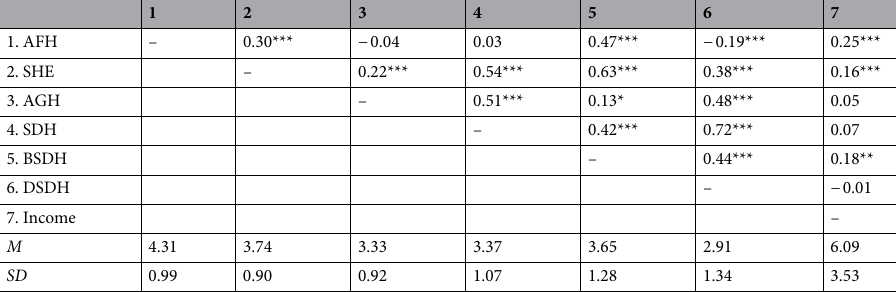
Table 1. Means, SDs, and zero-order correlations among study variables. AFH affiliative humor, SHE self- enhancing humor, AGH aggressive humor, SDH self-defeating humor, DSDH deleterious SDH, BSDH benign